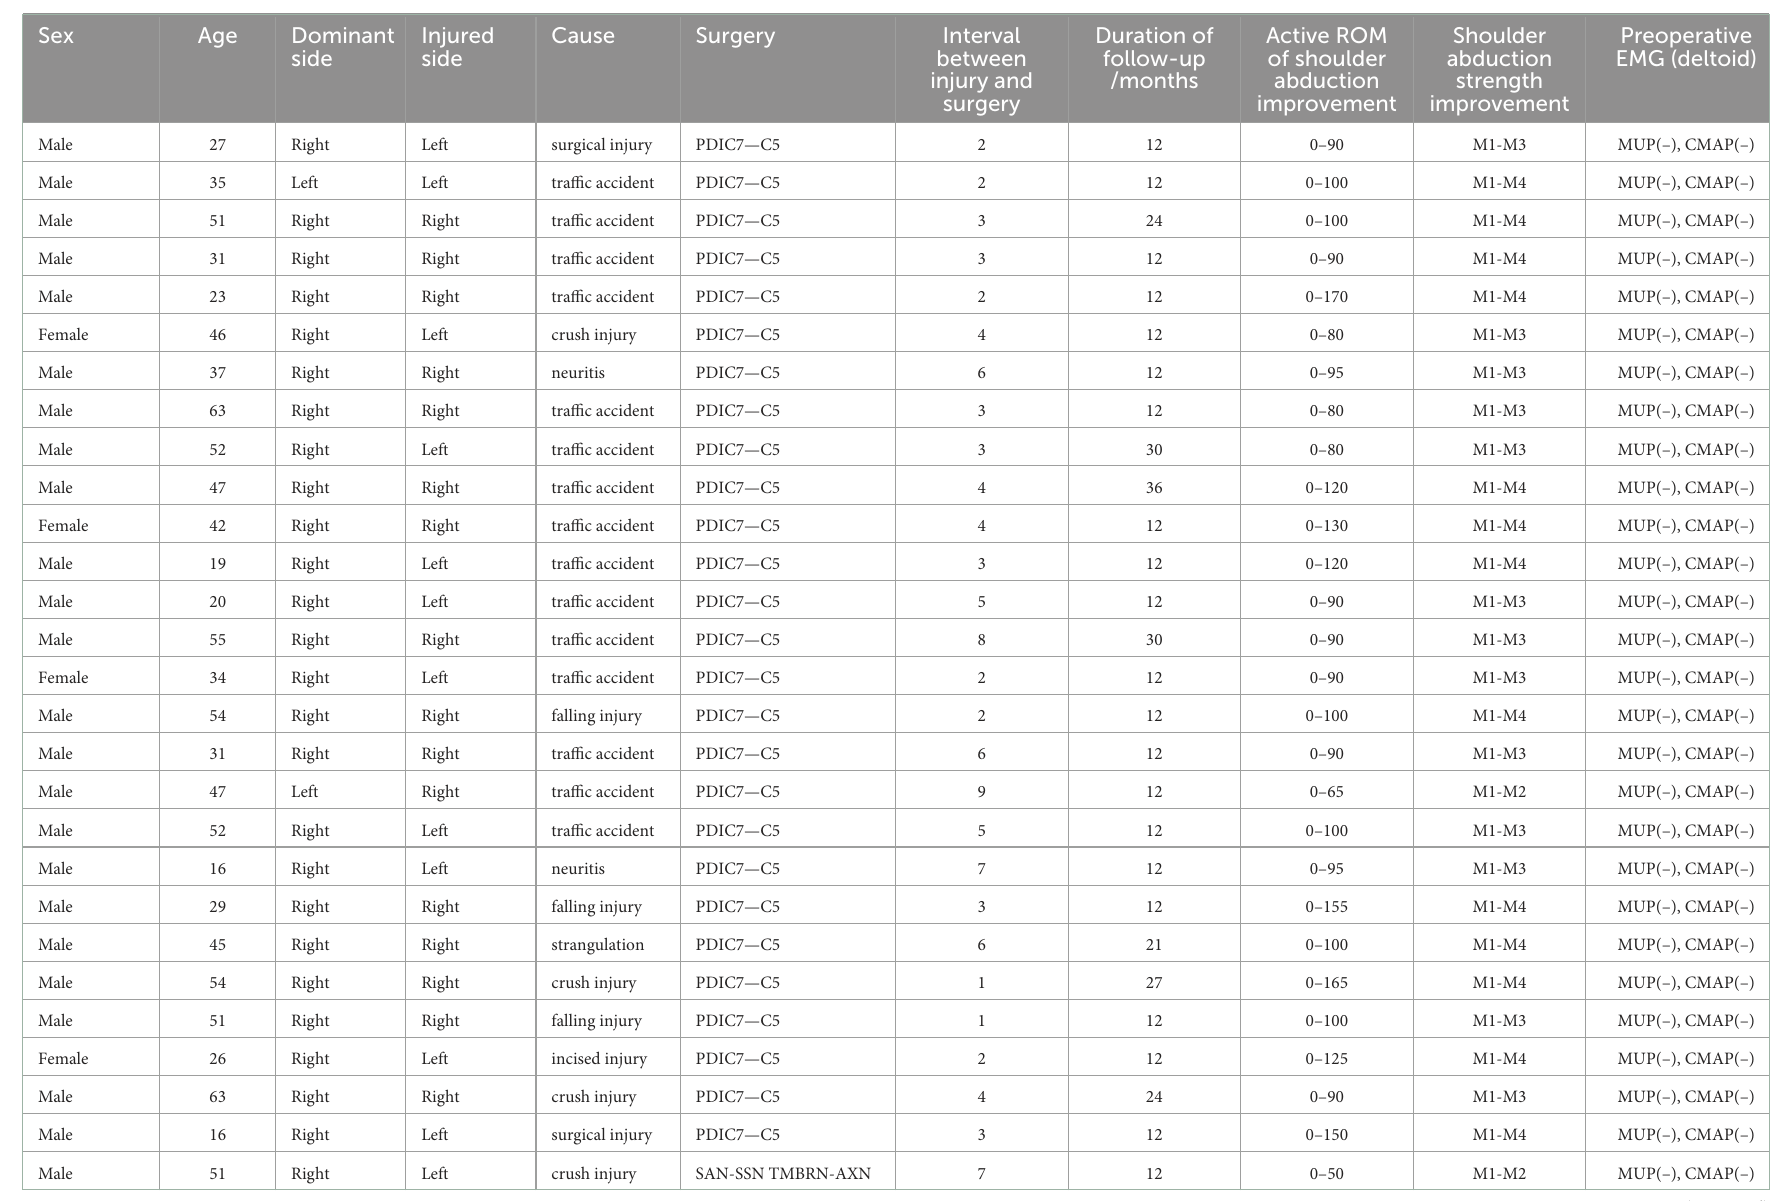
TABLE 2 Detailed information on patients who underwent one of the two types of